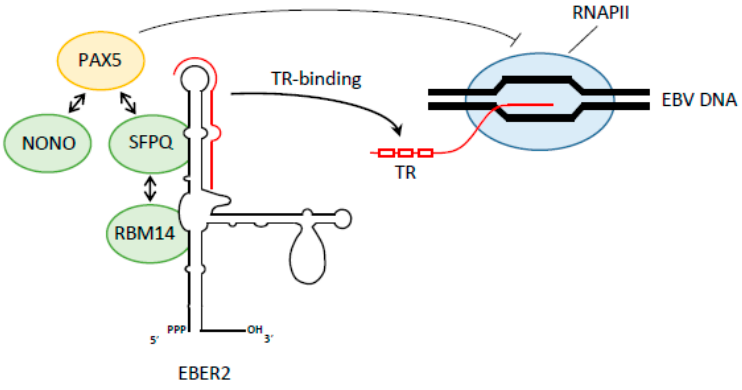
Figure 4. Factors involved in Epstein-Barr virus-encoded RNA (EBV EBER) transcription regulation. RNA structure of EBER2 non coding RNA (black) with the terminal region (TR) binding domain indicated in red. EBER2 recruits several protein factors to the nascent EBV RNA. See the text for more details.